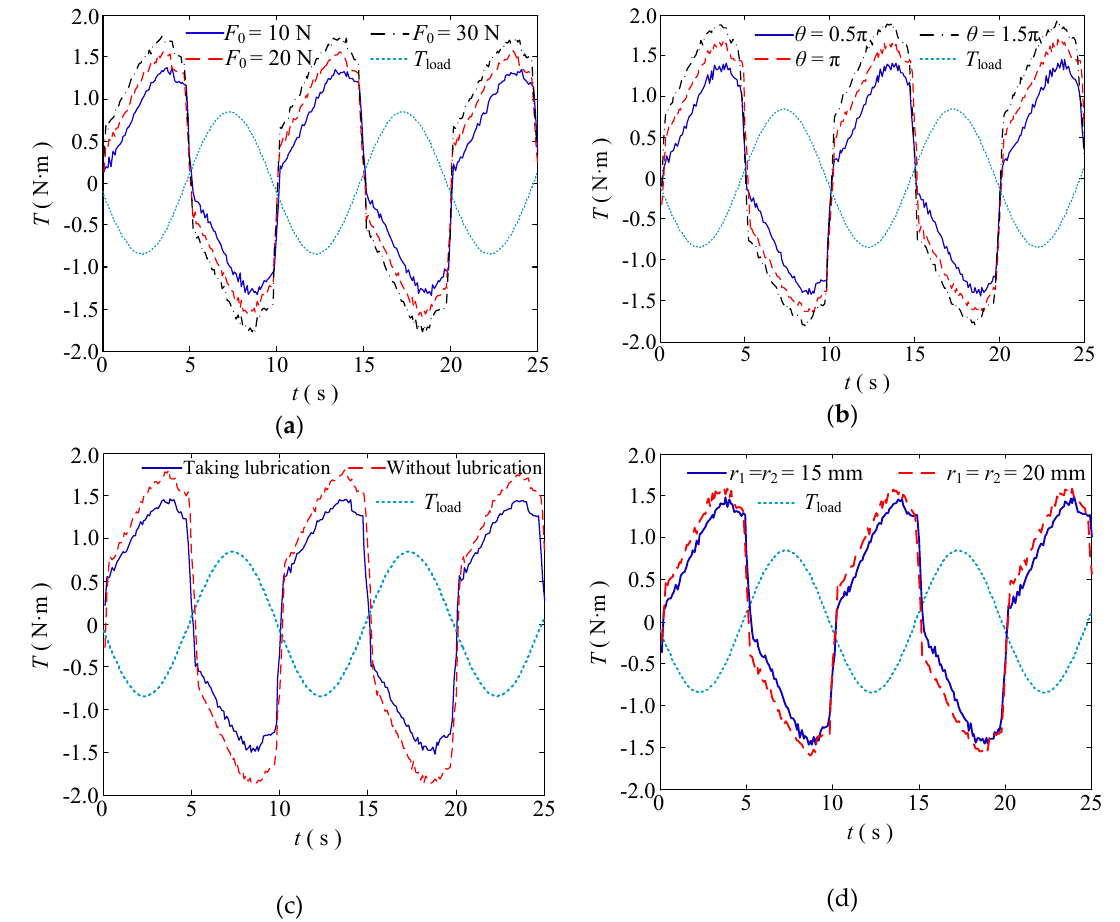
Figure 9. Transmission efficiency analysis for the double tendon-sheath torque; ( a ) torque transmission efficiency with different preload; ( b ) moment transfer efficiency at full curvature of different tendon-sheathes; ( c ) torque transmission efficiency under different friction factors; ( d ) torque transmission efficiency with different preload.